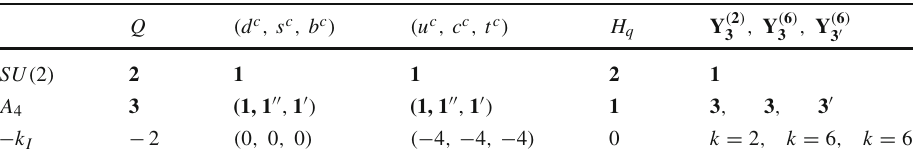
Table 1 Assignments of representations and weights − k I for MSSM fields and